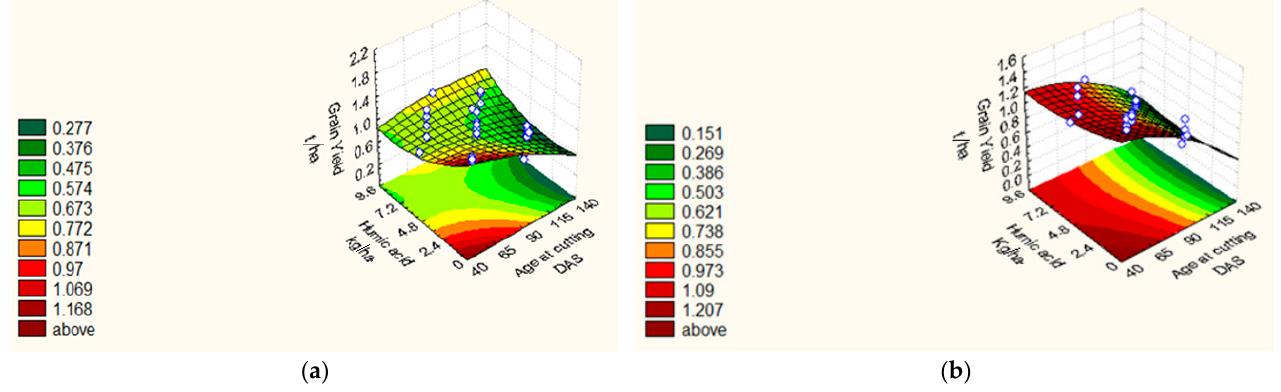
Figure 10. Response surface for grain yield as affected by AC and HA at the central levels of AC and HA in ( a ) 2018/19 and ( b ) 2019/20.